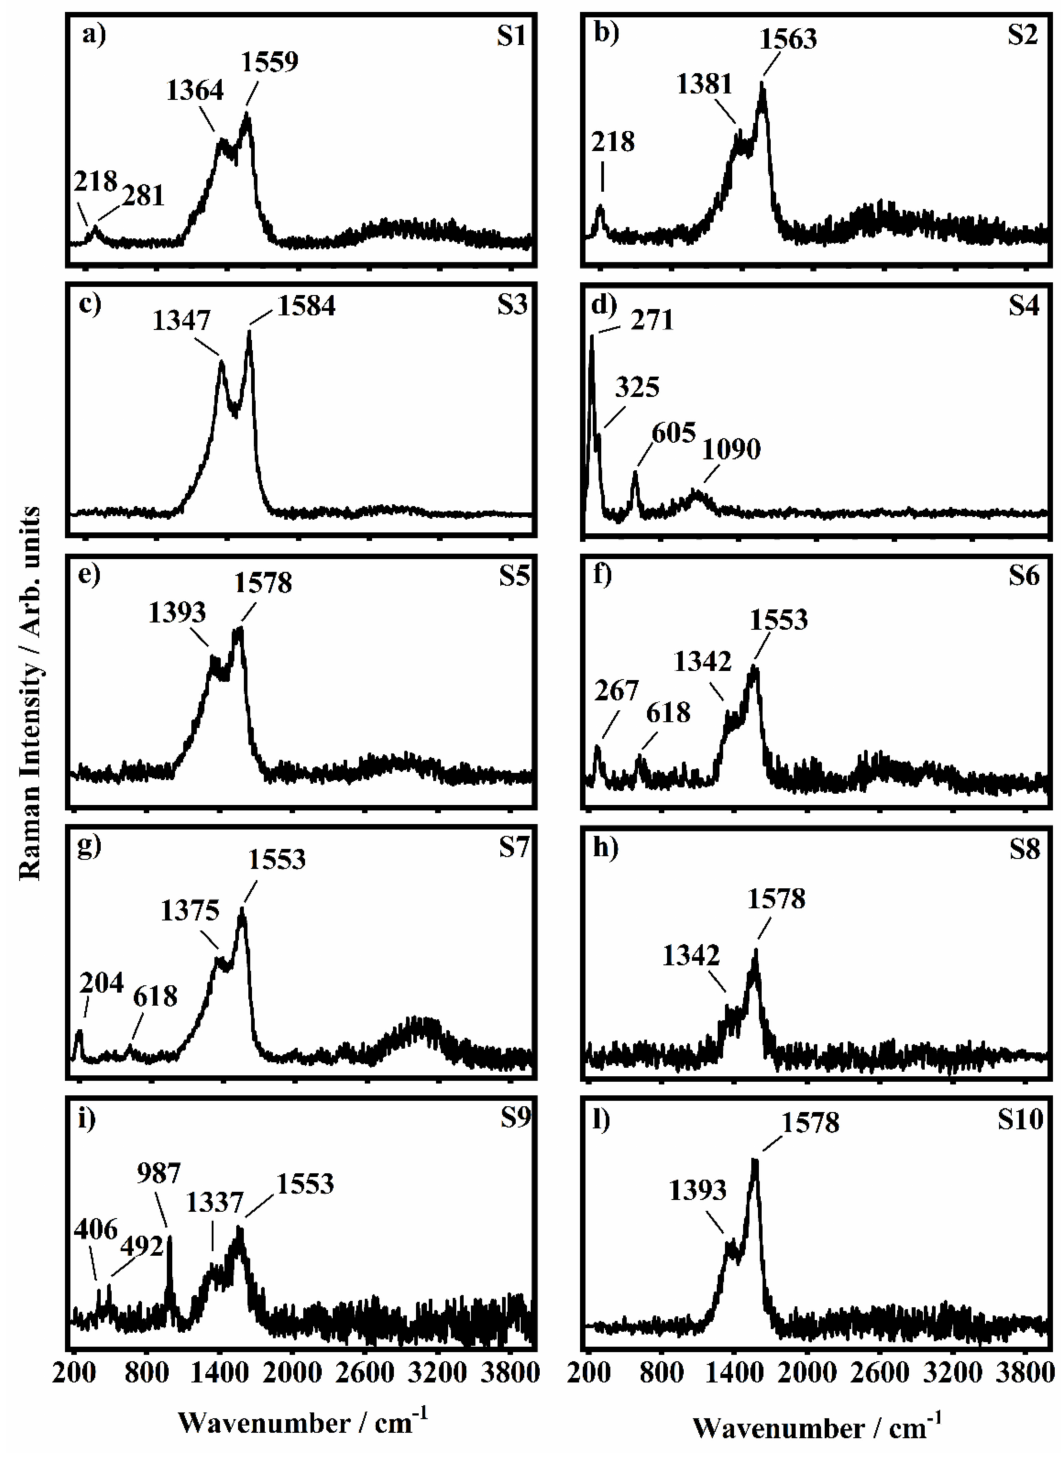
Figure 2. Representative Raman spectra of the specimen N. 01.1622 collected on the 10 sectors labeled as ( a ) S1, ( b ) S2, ( c ) S3, ( d ) S4, ( e ) S5, ( f ) S6, ( g ) S7, ( h ) S8, ( i ) S9 and ( l ) S10 in the spectral range from 150 to 4000 cm − 1 , and by using a laser source at 514